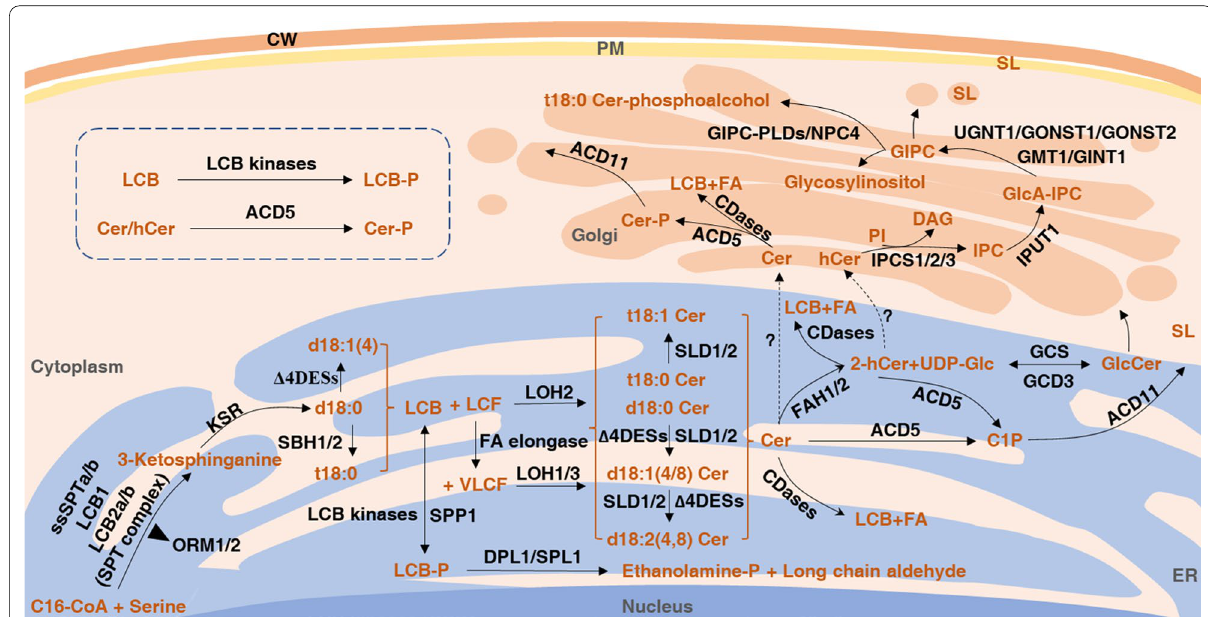
Fig. 1 Sphingolipid metabolism pathway. Enzymes or proteins involved in sphingolipid metabolism pathways are in black type. A dotted line with a question mark means that the details are unknown. A dashed box means that the enzymes inside are not in the ER or Golgi. ER, endoplasmic reticulum; SL, sphingolipid; FA, fatty acid; LCF, long‑chain fatty acid; VLCF, very‑long‑chain fatty acid, LCB, long‑chain base; d18:0, sphinganine or dihydrosphingosine; d18:1, sphingosine; d18:2, sphingadiene; t18:0, phytosphingosine or 4‑hydroxysphinganine; t18:1, 4‑hydroxysphingenine; Cer, ceramide; hCer, hydroxyceramide; GlcCer, glucosylceramide; GIPC, glycosyl inositol phosphoceramide; PI, phosphatidylinositol; DAG, diacylglycerol; SPT, serine palmitoyltransferase; SPT, serine palmitoyltransferase; LCB1 and LCB2a/b, subunits of SPT; ssSPTa/b, small subunits of SPT; ORM1/2, orosomucoid‑like proteins; 3‑KSR, a 3‑ketodihydrosphingosine reductase; SBH1/2, sphingoid base hydroxylases; Δ4‑DESs, Δ4‑desaturases; LOH1/2/3, ceramide synthases named LAG ONE HOMOLOGUES; ACD5, a ceramide kinase named ACCELERATED CELL DEATH 5; ACD11, a Cer‑P transporter named ACCELERATED CELL DEATH 11; PLM, phloem unloading modulator; FAHs, fatty acid alphahydroxylase; CDases, ceramidases; GCS, a glucosylceramide synthase; DPL1/SPL1, a LCB‑P lyase; SPP1, a phyto‑S1P phosphatase; IPCS1/2/3, inositolphosphorylceramide synthases; IPUT1, an inositol phosphorylceramide glucuronosyltransferase; GMT1, a GIPC mannosyl‑transferase; GINT1, a glucosamine inositol phosphorylceramide transferase; GONST1/2, Golgi‑localized nucleotide sugar transporters; UGNT1, an UDP‑ N ‑acetyl‑ D ‑glucosamine transporter; GCD1/2/3/4, glucosylceramidases; GIPCPLD, a GIPC‑specific phospholipase D; NPC4, a nonspecific phospholipase